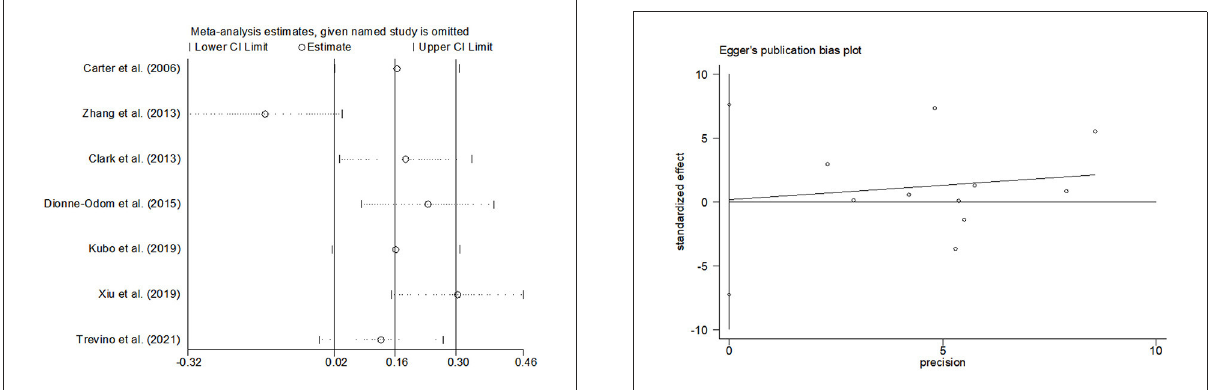
FIGURE6 Publication bias test of CBT effect on QOL.